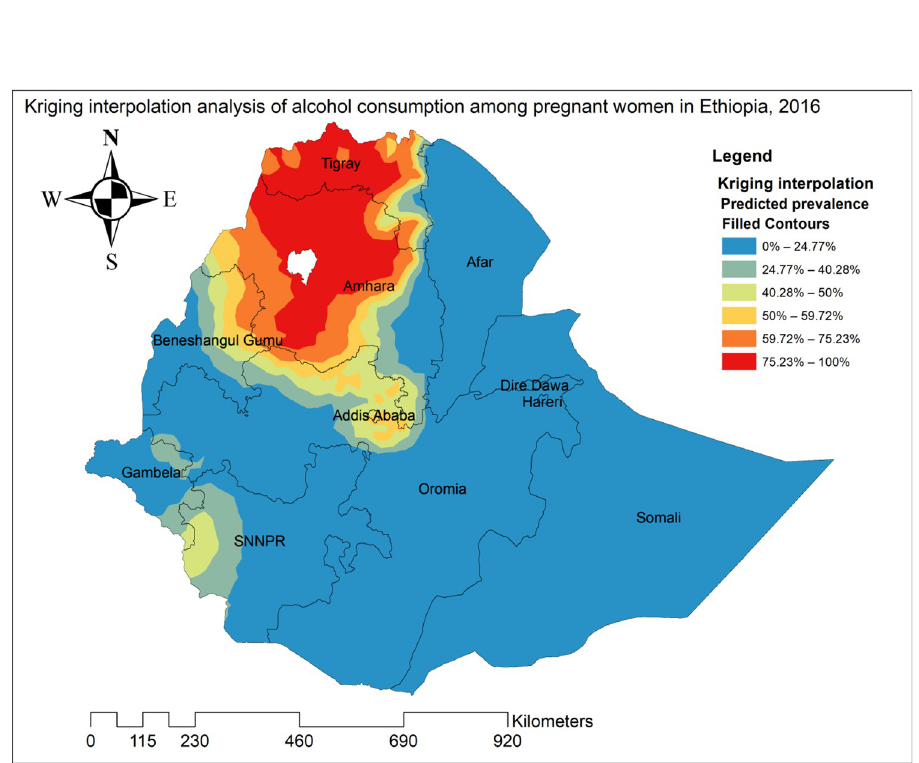
Fig 5. Spatial interpolation of alcohol consumption among pregnant women in Ethiopia, 2016.